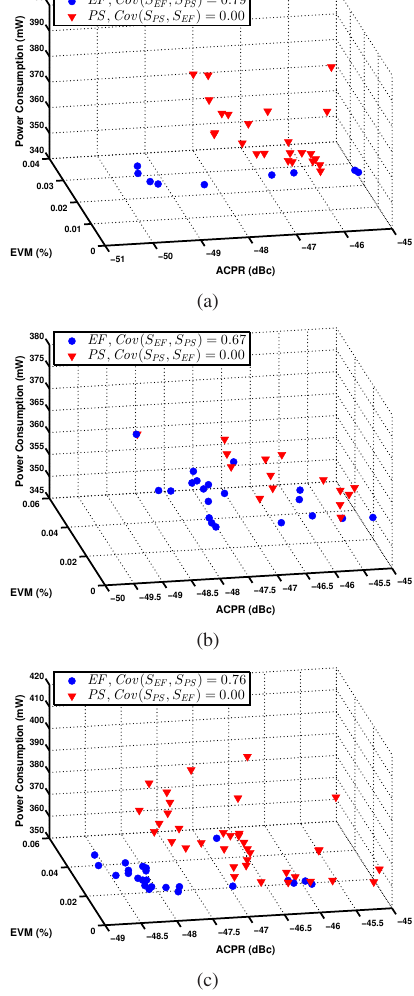
Figure 4. Pareto-optimized solutions obtained from the EADI Framework and PS for (a) QPSK, (b) 16–QAM, (c)